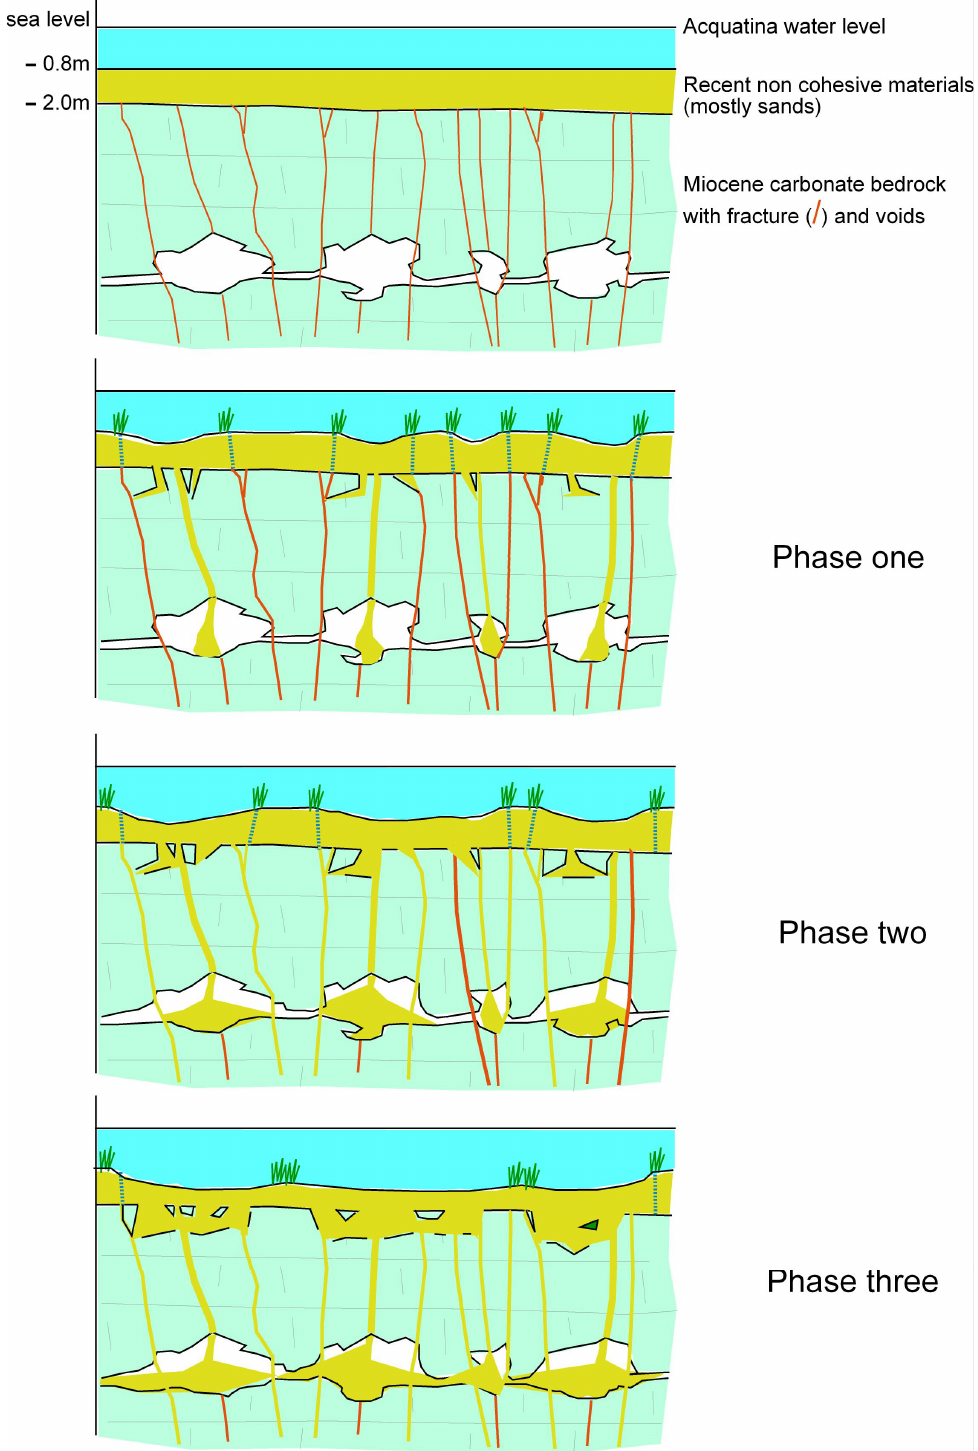
Figure 14. Sketch of the sinkhole evolution (not to scale). Please note that the first sinkholes developed in correspondence of the two artificial canals, probably because of the reduced thickness of the recent sands. Phase one: sands move down into the voids, which are progressively enlarged by the joints, thus forming small depressions at the surface. Rising brackish water through the joints favours plants to take root; however, continuous settling of sands pushes them at the rims of the depressions. Phase two: both dissolution and sand infilling go on, and wider depressions are originated due to coalescing sinkholes. Phase three: continuing infilling determines a general lowering of the basin